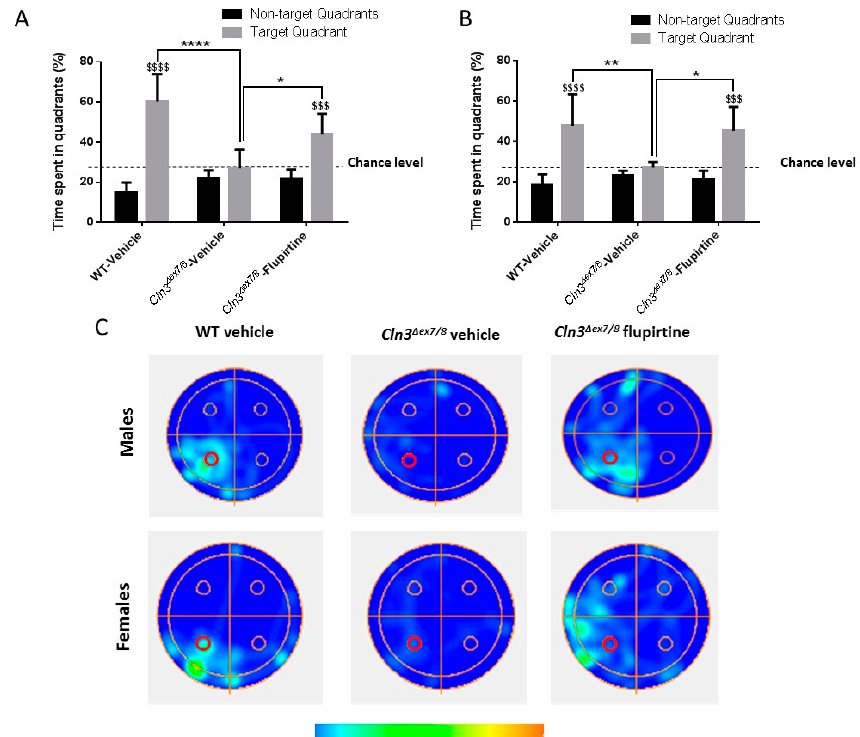
Figure 3. Impact of flupirtine on learning and memory of male and female Cln3 Δ ex7/8 mice. Percentage of time spent in target vs. non-target quadrant of ( A ) male and ( B ) female mice in the different groups (vehicle-treated WT, vehicle-treated Cln3 Δ ex7/8 , and flupirtine-treated Cln3 Δ ex7/8 ) during the probe test ( n = 8 per group). All data are expressed as mean ± SEM. $ p : Target quadrant compared to non-target quadrant; and * p : compared to vehicle-treated WT mice. * p < 0.05, ** p < 0.01, **** p < 0.0001, $$$ p < 0.001, and $$$$ p < 0.0001. ( C ) Representative heat maps of swimming paths of one mouse from different groups during the probe test in male and female mice. An empty, bolded red circle indicates location of the target platform ( ᴏ ).